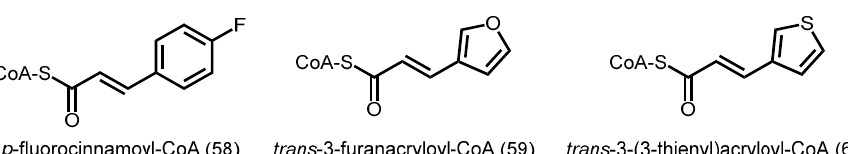
Figure 16. Starter acyl-CoA substrates utilized by A. hypogaea STS.